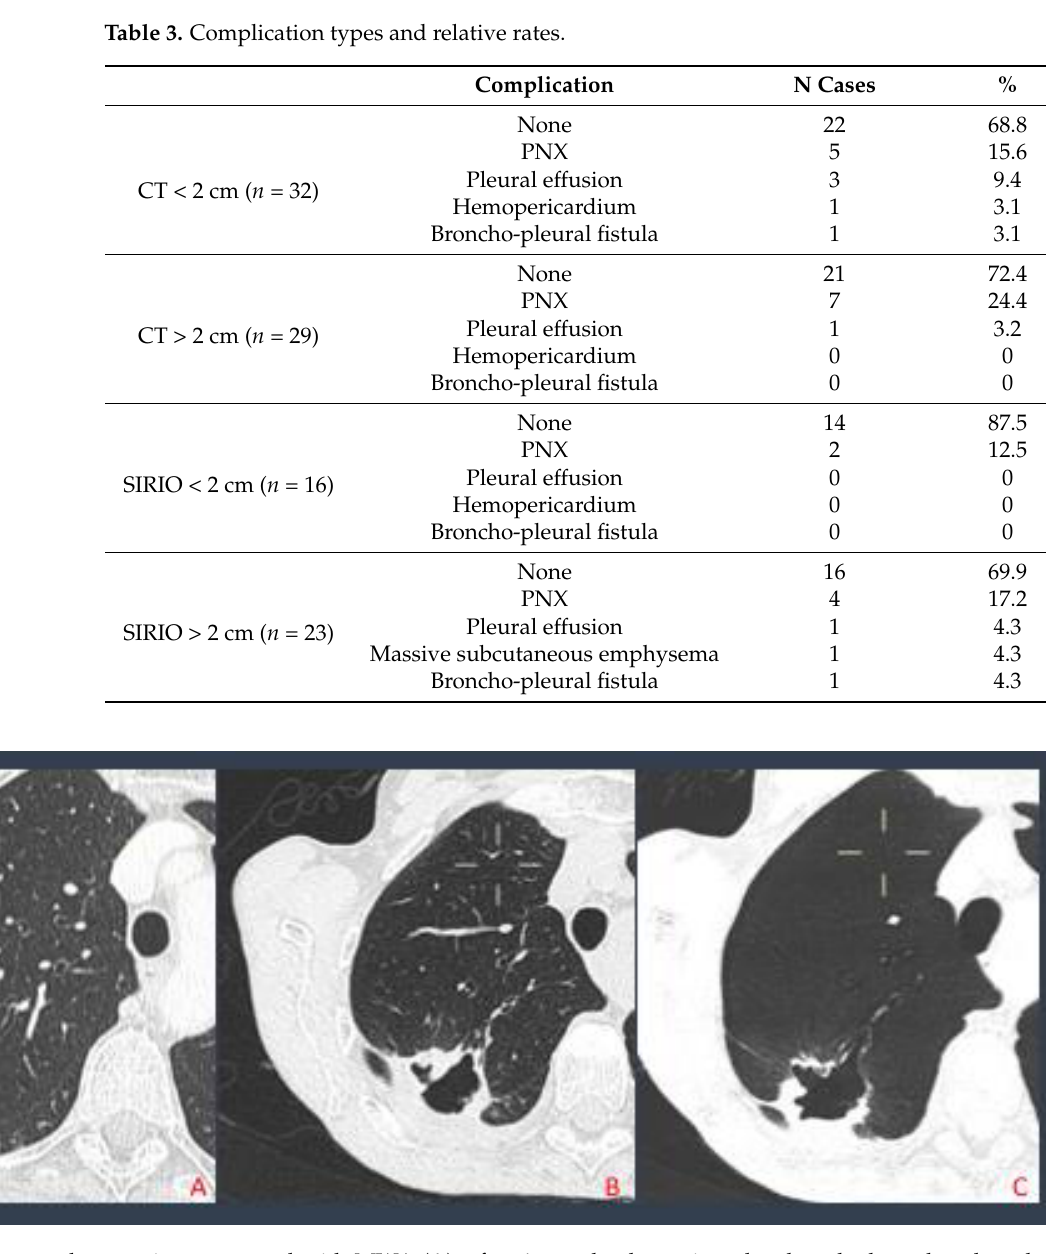
Figure 3. Pulmonary adenocarcinoma treated with MWA ( A ); after 4 months the patient developed a broncho-pleural fistula ( B ); MinPR reconstruction displaying the fistula ( C ). fistula ( B ); MinPR reconstruction displaying the fistula ( C